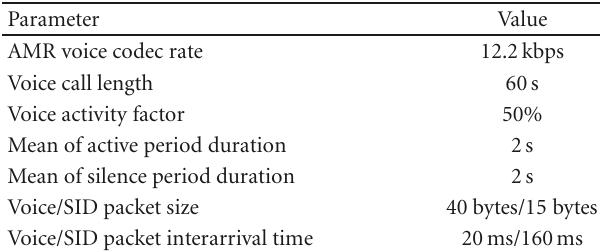
Table 2: VoIP tra ffi c characteristics.